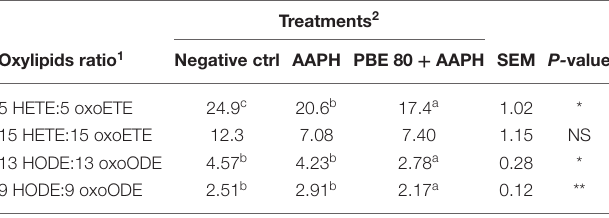
TABLE 3 | Ratio values of pro-inflammatory oxylipids and their corresponding anti-inflammatory forms. Treatments